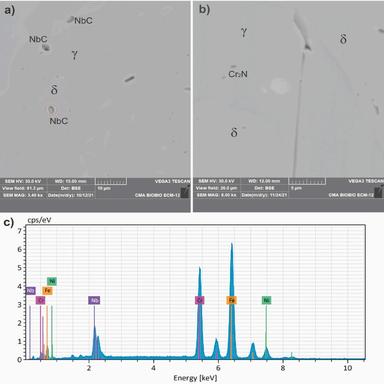
SEM-BSE images of SDSS-Nb, a) SDSS-Nb heat-treated at 1090 ◦C at 3400x magnification; b) SDSS-Nb heat-treated at 1090 ◦C at 8000x magnification; c) EDS spectrum of NbC phase in SDSS-Nb heat-treated at 1090 ◦C zone with white segmented line circle in figure "a".